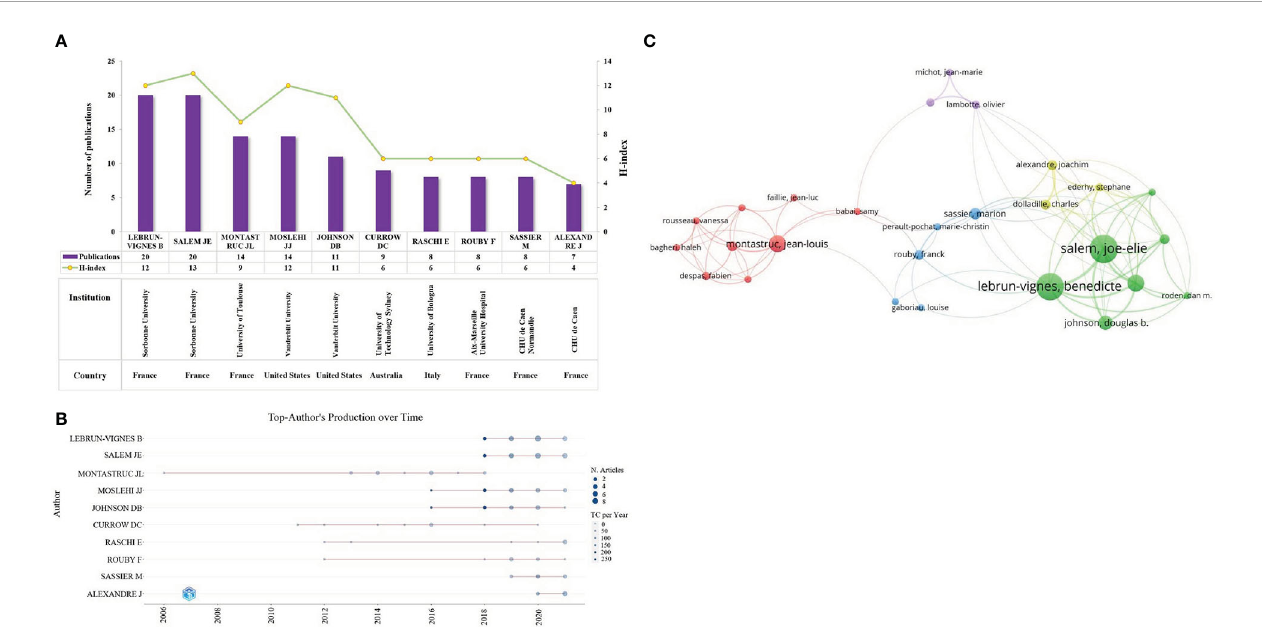
FIGURE 5 Co-authorship analysis. (A) The top ten authors with a high volume of publications and their H-index. The purple bars indicate the publications count, while the yellow nodes represent the H-index. (B) Annual production of the top 10 authors. The x-axis and y-axis represent the year and author, respectively. The larger the node, the more publications, and the darker the node ’ s color, the higher citations. (C) Cluster diagram of authors with more than 5 publications. The size of a node indicates the number of publications of an author. Clusters of the same color represent more active collaboration. Line thickness and distance between nodes indicate the relative strength of the